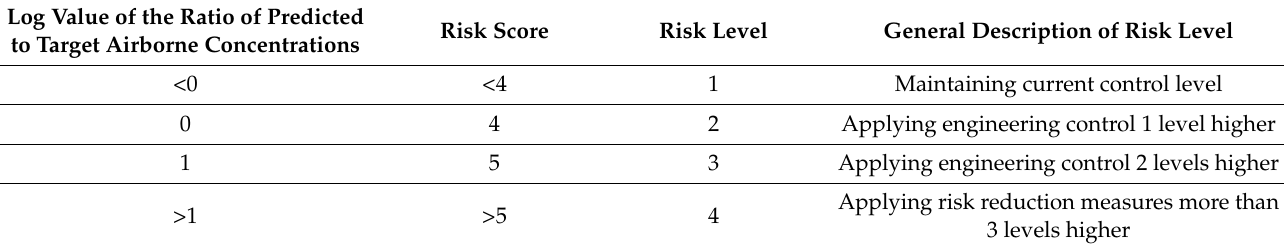
Table 6. Characterization of risk level from risk